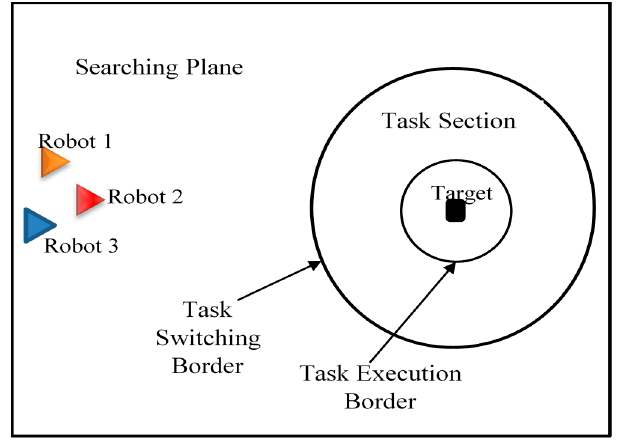
Figure 2. Three phase zones (Search, Task, and Execution